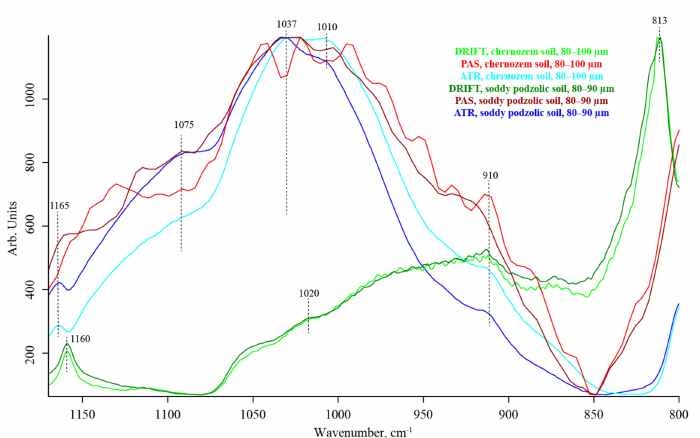
Figure 9. Normalized FTIR spectra in 1170–800 cm − 1 . DRIFT, ATR, and PAS (IMF 1.6 kHz) spectra of shelterbelt chernozem soil (dry fractionation, 80–100 µ m), light green, light blue, and light red, respectively; and DRIFT, ATR, and PAS (IMF 1.6 kHz) spectra of sod-podzolic soil (dry fractionation, 80–90 µ m), dark green, dark blue, and dark red,